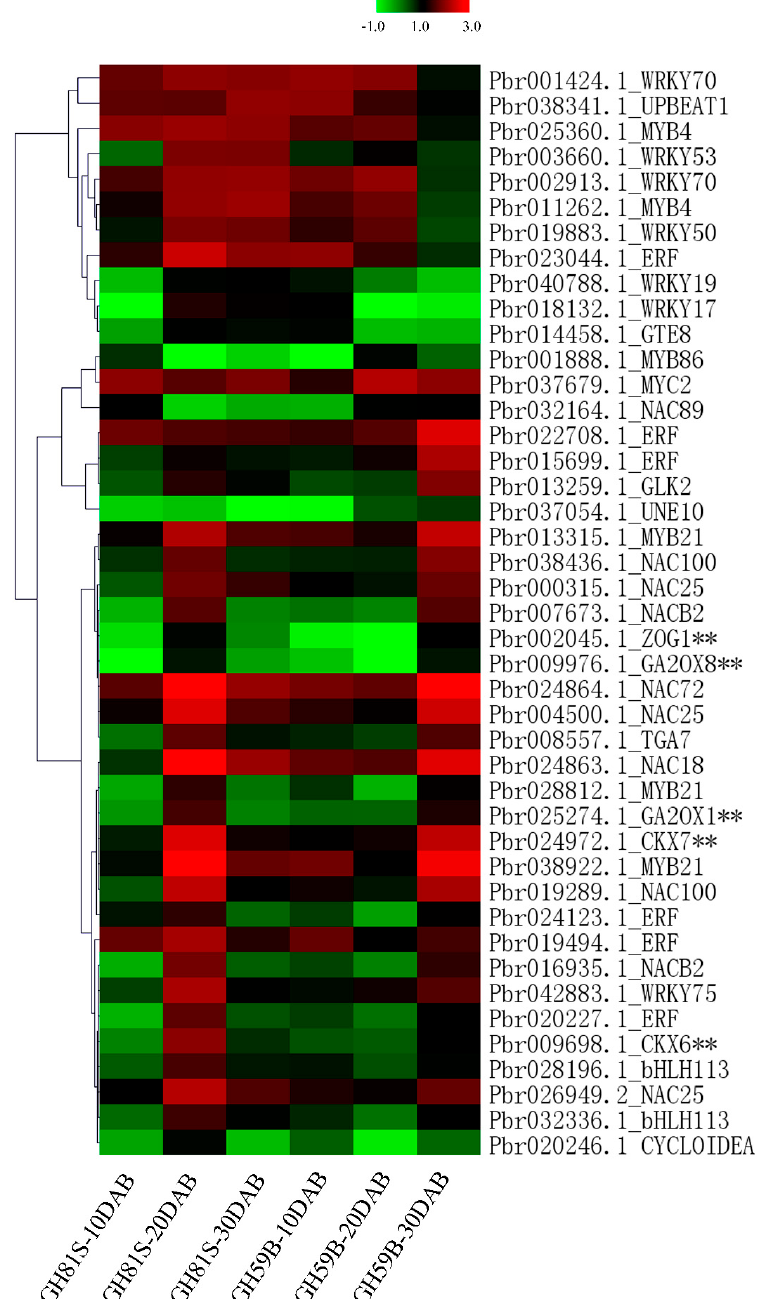
Figure 5. Heatmap of the expression of transcription factors.